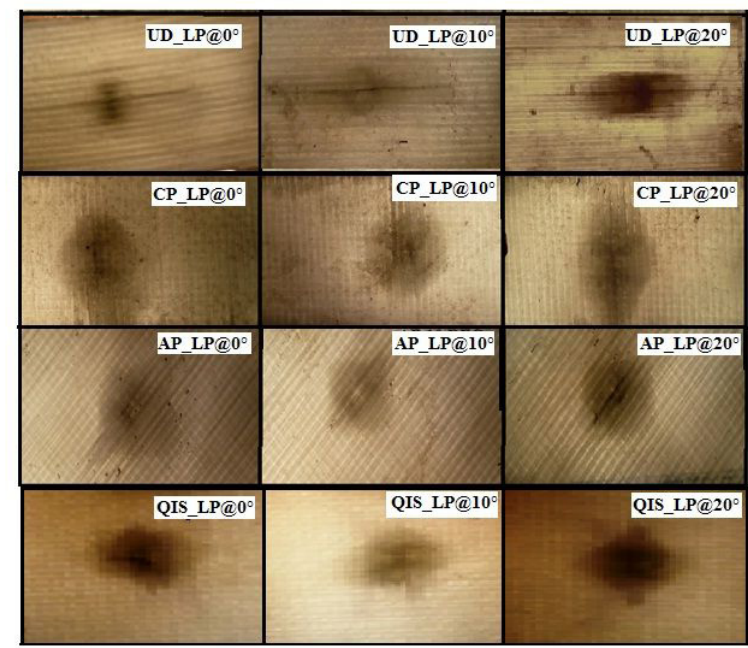
Figure 10. Rear side photographic view of indented glass/epoxy laminates under different loading planes